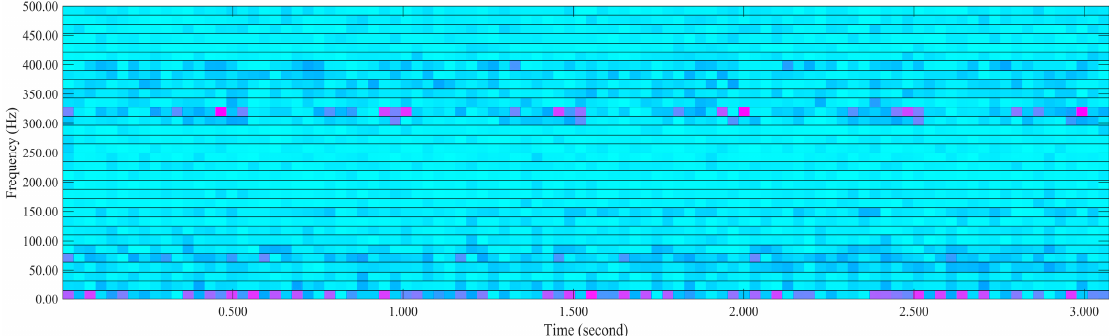
Figure 8. The wavelet packet tree of the vibration signal.